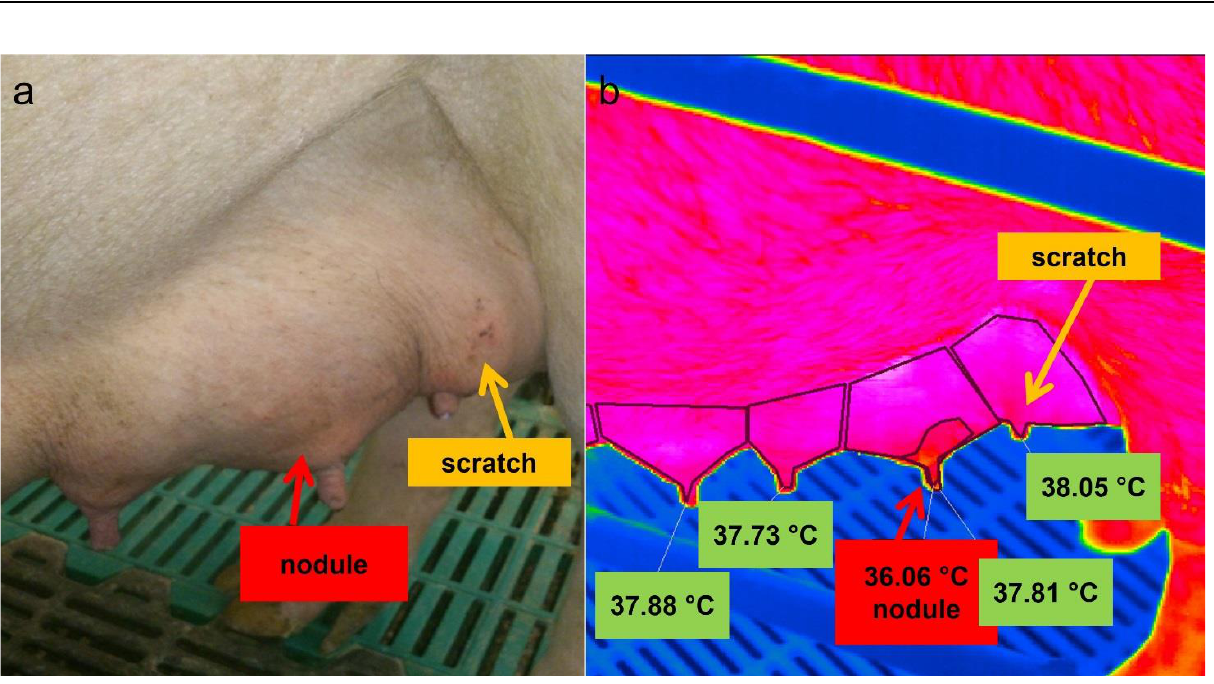
Figure 6. Picture ( a ) and thermal image ( b ) of the left side of a sow´s udder. The mean surface temperature (36.06 °C) of an area above the nodules and of the affected total mammary gland as a whole (37.81 °C) were given as well as the mean skin temperature of the adjacent glands; a scratch is marked by a yellow arrow.